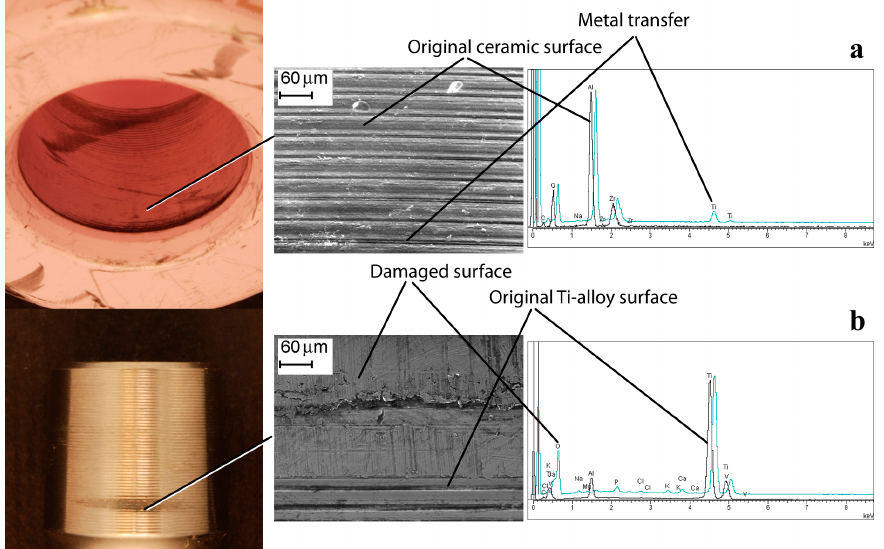
Figure 5. The bore of a ceramic head and the male taper of its Ti-alloy neck. Metal transfer is visible in the head bore. The male taper is damaged specularly. EDX spectra of ceramic and material spread on ceramic surface ( a ), and Ti-alloy and fretted area ( b ) are shown.